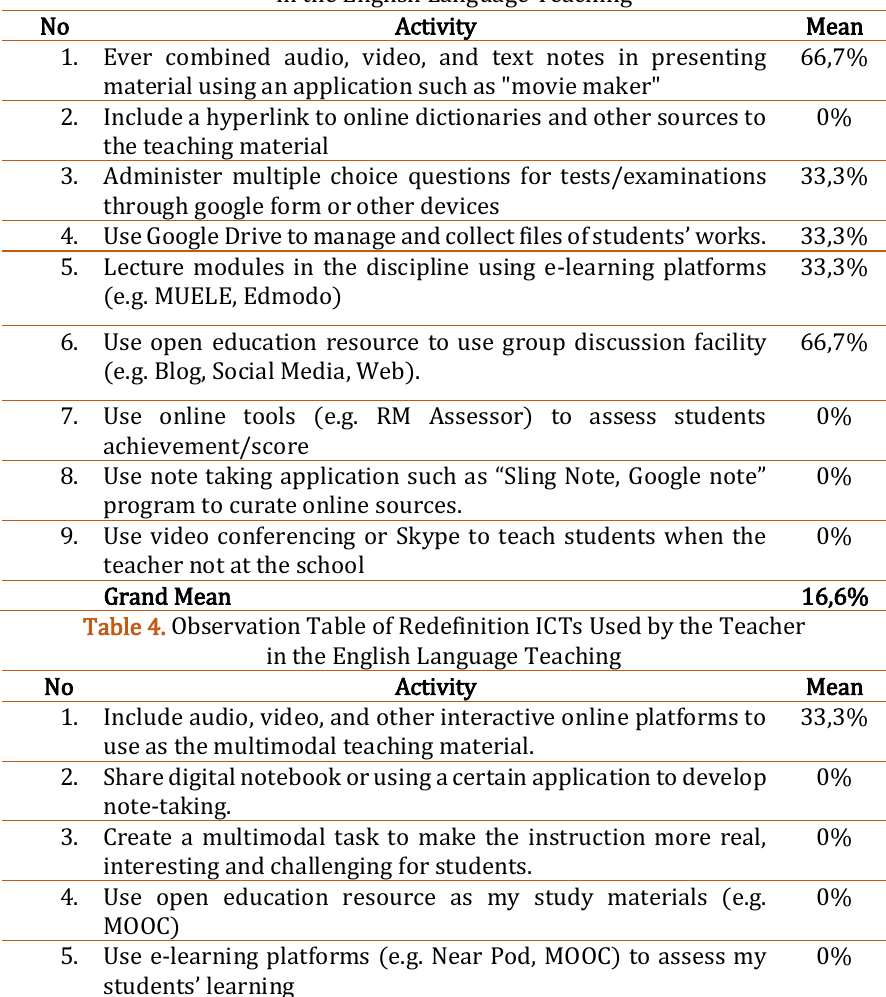
Table 3. Observation Table of Modification ICTs Used by the Teacher